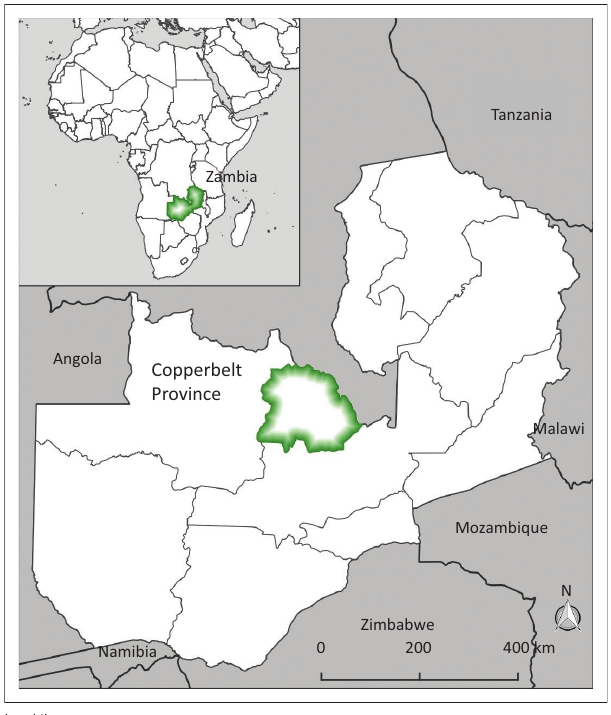
km, kilometres. FIGURE 3: Map showing the location of Zambia in Africa (inset) and the Copperbelt province in Zambia where the socio-economic surveys were